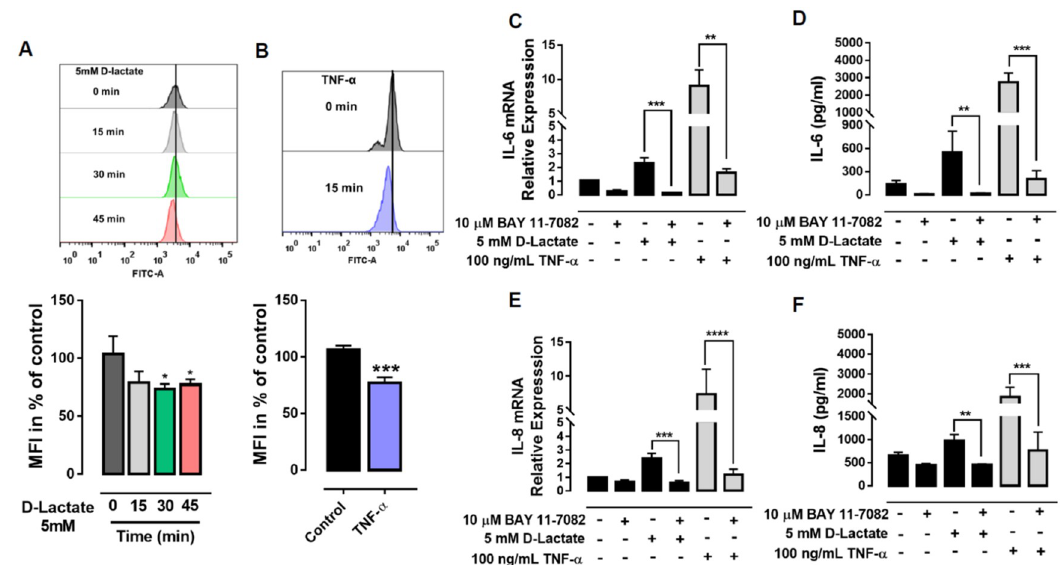
Figure 6. NF-κB regulates the increase in the expression and secretion of IL-6 and IL-8 induced by D-lactate in bFLSs. IκBα degradation was evaluated in cells treated with ( A ) D-lactate and ( B ) bTNF-α by flow cytometry. The cells were treated with BAY 11-7082, an NF-κB inhibitor, and then treated with D-lactate or bTNF-α. ( C , E ) The mRNA levels of IL-6 and IL-8 normalized by RPS9 in cells treated with D-lactate or bTNF-α are shown. ( D , F ) The concentrations of IL-6 and IL-8 in cells treated with D-lactate or bTNF-α are shown. The mean ± standard error of media (SEM) of five independent experiments is shown. * p < 0.05, ** p < 0.01; *** p < 0.001; **** p < 0.0001 compared with control or D-lactate-treated cells.